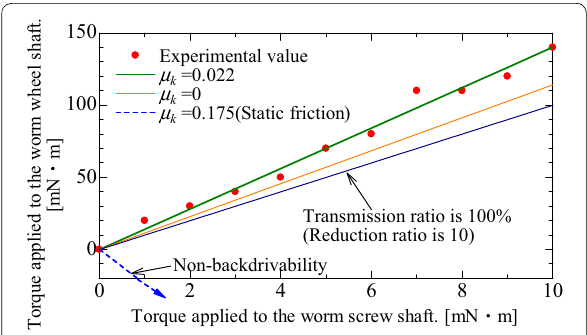
Fig. 11 Torque transmission ratio when the exciting force is applied to the shaft of the worm